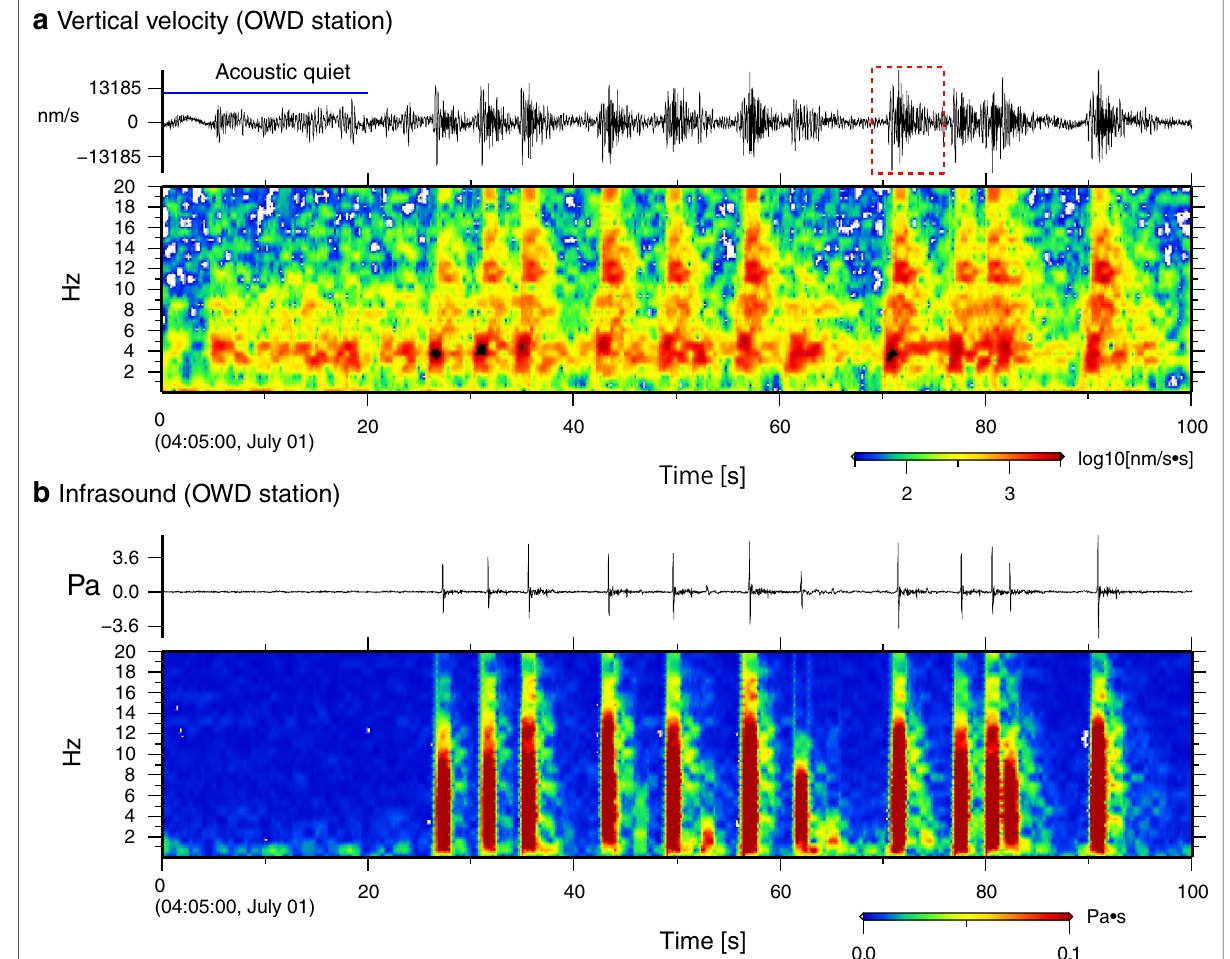
Fig. 11 Vertical velocity and acoustic signals recorded at OWD station during the eruption. a The raw seismometer signal (top) and spectrogram (bottom); b the raw signal (top) and spectrogram (bottom) from a microphone, for a period of 100 s starting from 04:05 on July 1, 2015. The acoustic signal was corrected using the result of sensor calibration (Yukutake et al. 2017). Each spectrogram was calculated by using a 1.28 s time window with 0.05 s